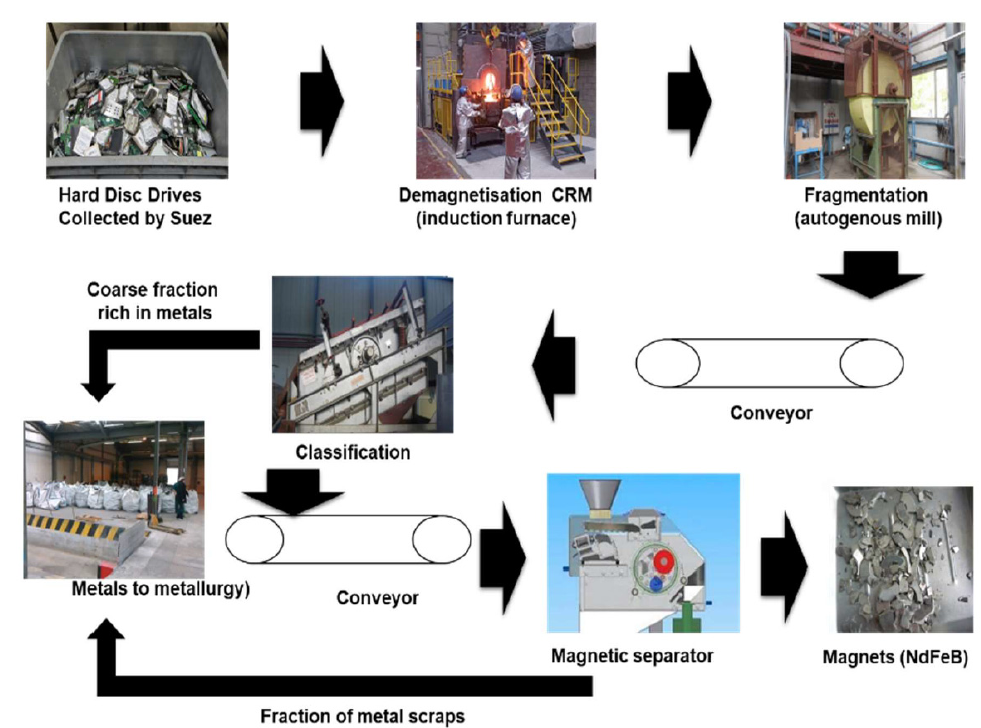
Figure 3. Global flowsheet of HDD magnets treatment .